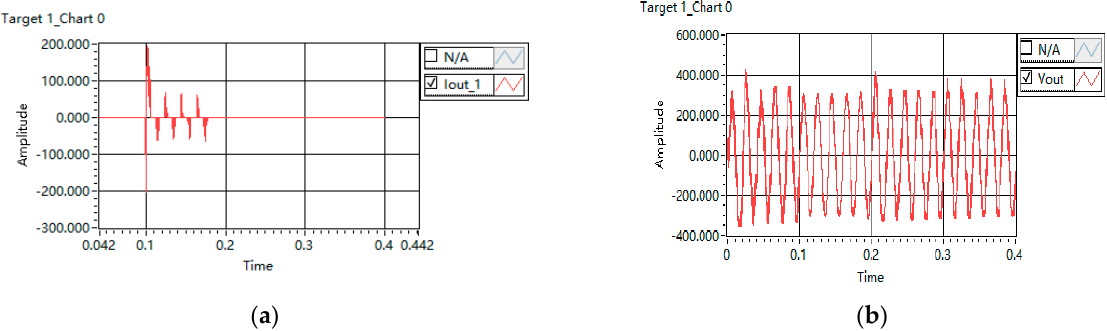
Figure 15. Experimental results of UPS with only dynamic switching method ( a ) output current of phase A, ( b ) output voltage of phase A. In Figure 15a,b: output current of phase A i oA , output voltage of phase A U oA .